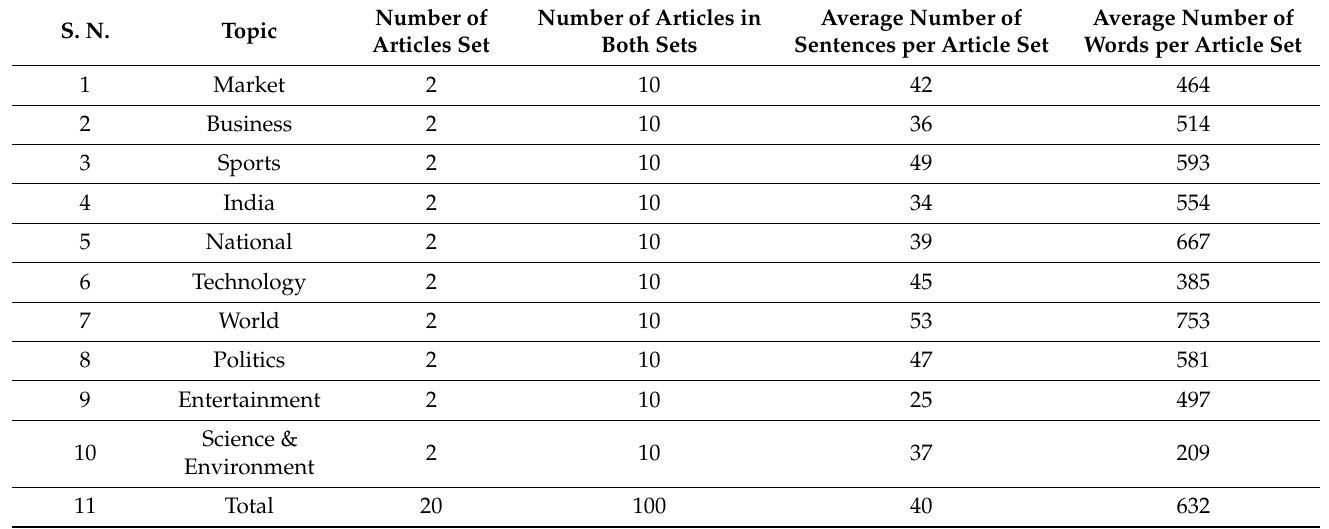
Table 4. Analysis of dataset.